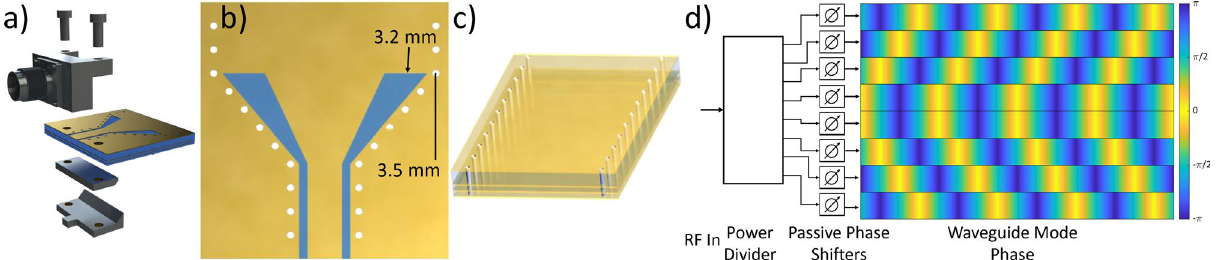
Figure 3. Waveguide structure underlying the Nyquist metasurface antenna. ( a ) shows an end launch connector which excites a CPW. ( b ) shows the transition from CPW to the SIW shown in ( c ). ( d ) shows the RF